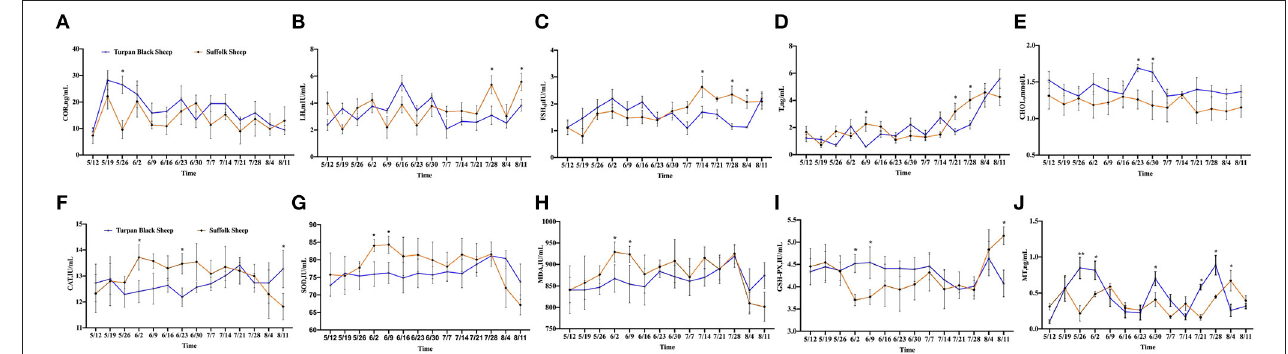
FIGURE 2 | Changes of reproductive hormones and antioxidant indices during HS. (A) Hydrocortisone. (B) Luteinizing hormone. (C) Follicle-stimulating hormone. (D) Testosterone. (E) Total cholesterol. (F) Catalase. (G) Superoxide dismutase. (H) Malonaldehyde. (I) Glutathione synthetase. (J) Melatonin. Significance was calculated by T -test, *means P < 0.05, ** means P < 0.01.